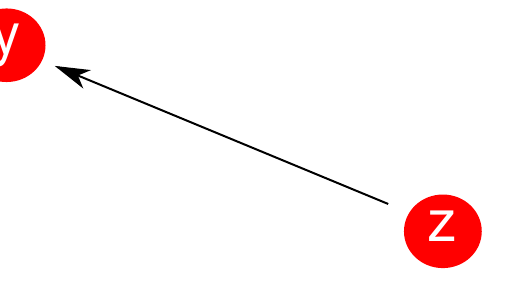
Figure 2. The directional derivative of f from z to y . This actually represents the (finite) variation of f for the information going from node z to node y . It is positive if y gets more information than z , and negative otherwise. This concept makes sense only if y and z are neighbors; hence, the presence of a yz ∈ { 0,1 } in the